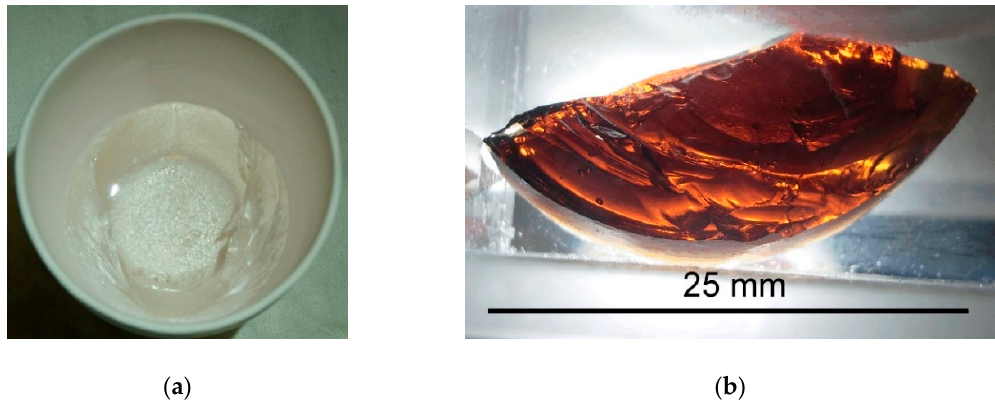
Figure 1. Sample of non ‐ radioactive borosilicate glass «B ‐ Si» in an alumina crucible ( a ) and a fragment of sample «B ‐ Si_238» doped with 0.45 wt.% 238 Pu ( b ).